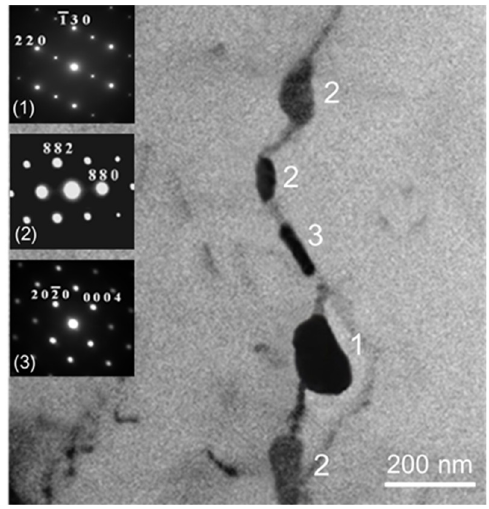
Figure 5. TEM photomicrograph of as-cast alloy D (1: MnAl 6 , 2: Mg 2 Al 3 , 3: MgZn 2 ).